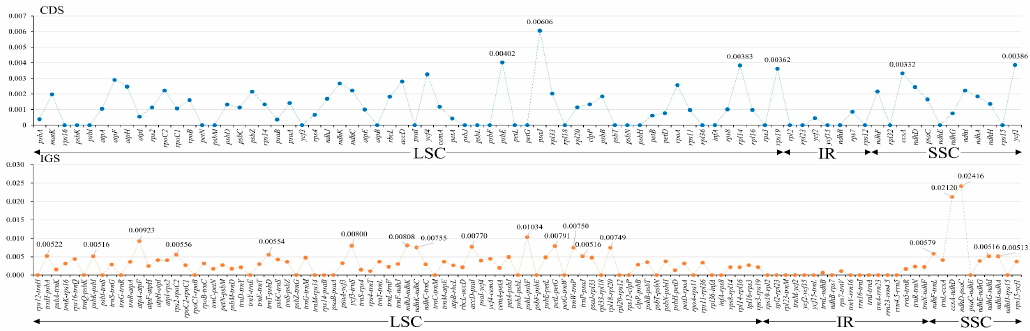
Figure 7. Nucleotide diversity (Pi) in the chloroplast genome of five Magnoliaceae species ( Michelia shiluensis ; Michelia odora ; Magnolia laevifolia ; Magnolia insignis ; and Magnolia cathcartii ).